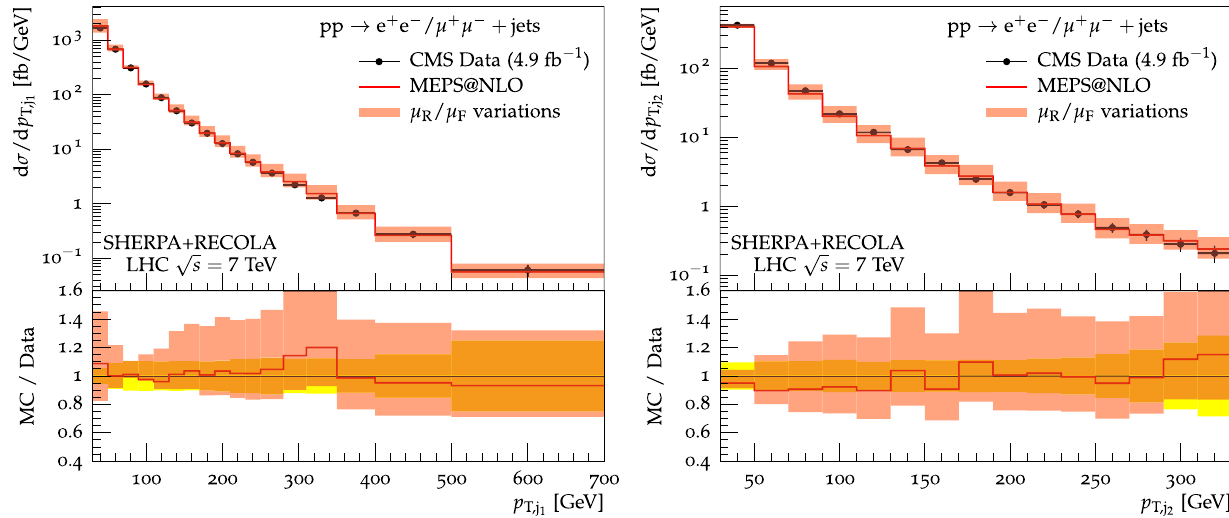
Fig. 6 Transverse-momentum distribution of the first ( left panel ) and second ( right panel ) hardest jet for Drell–Yan production at the LHC with √ s = 7TeV. The MEPS@NLO predictions from Sherpa + Recola are compared to CMS data from Ref. [72] (uncertainty bands as in Fig.